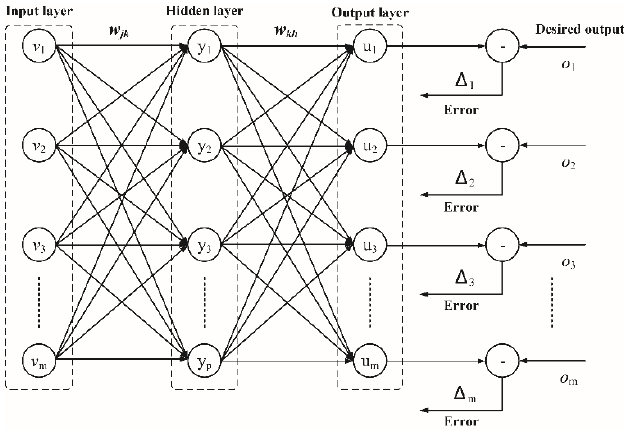
Figure 6. BP neural network structure.